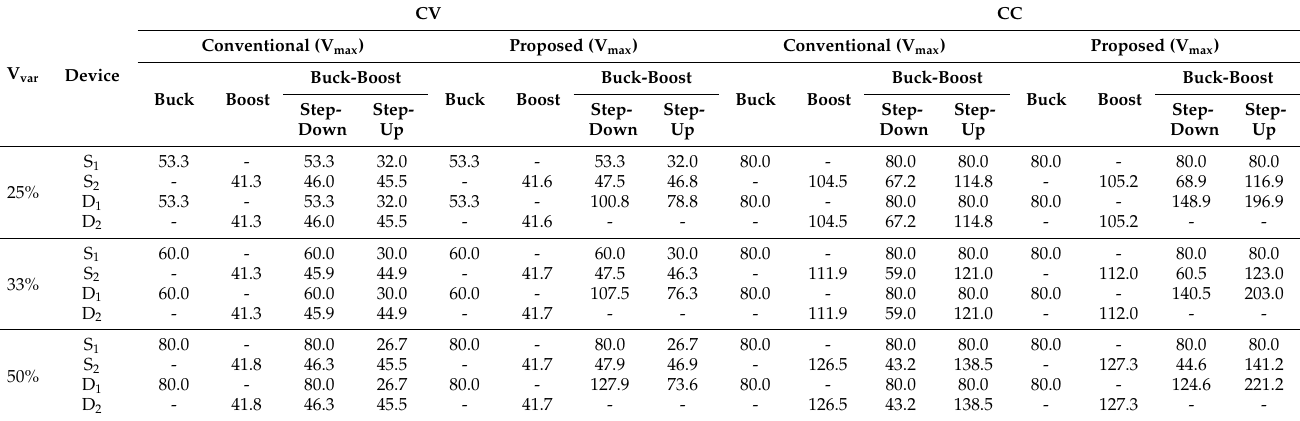
Table 8. Measured maximum voltage stresses on components in CV and CC modes.